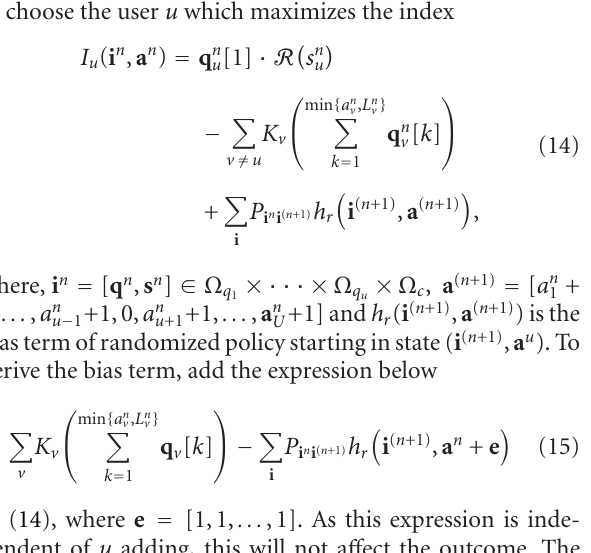
Figure 5: Scheduling in shared wireless